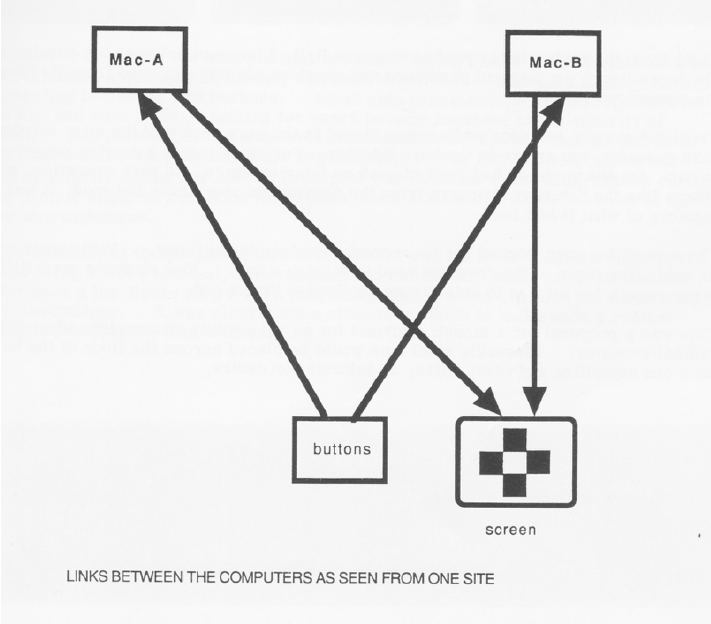
Figure 7. Diagram of one unit of Communications Game in the ‘Art Creating Society’ exhibition, 1990. Illustration from Edmonds (1990).